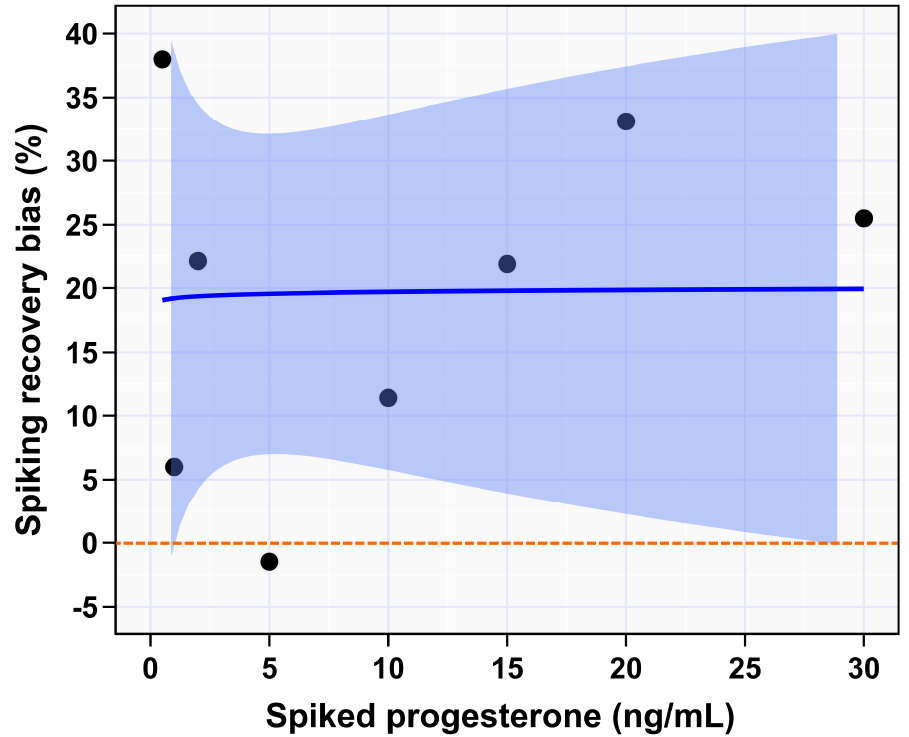
Figure 3. Spiking-recovery bias percentage of IMMULITE ® 2000 XPi P4 immunoassay across the spiked serum. The shaded blue area indicates 95% CI of mean difference. Dark blue line indicates the fitted regression line.